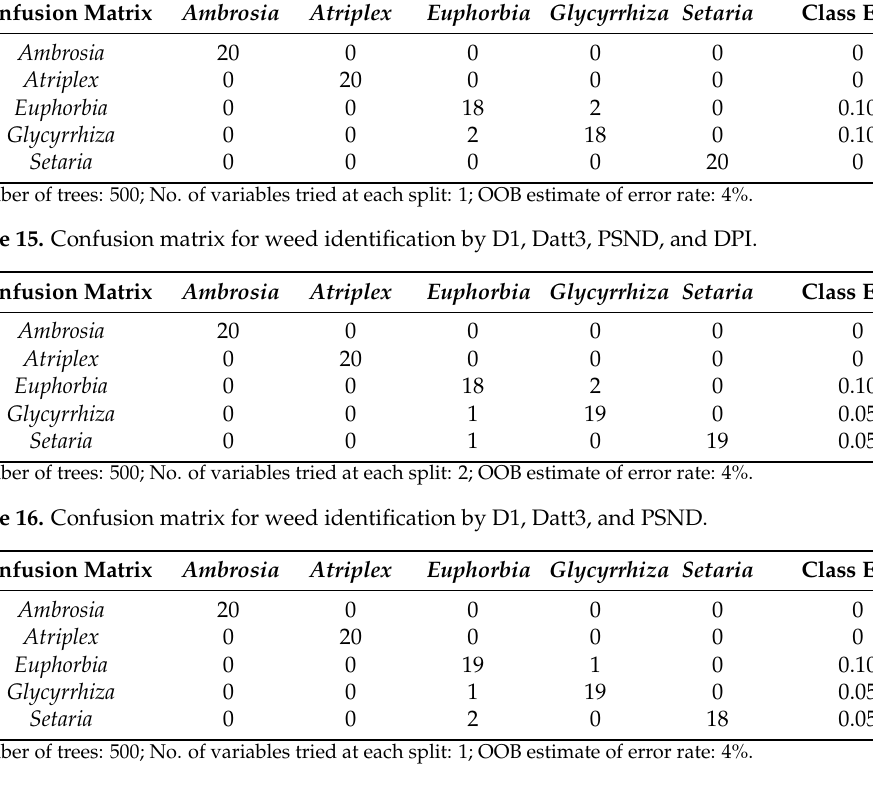
Table 14. Confusion matrix for weed identification by D1, Datt3, and CI. Confusion Matrix